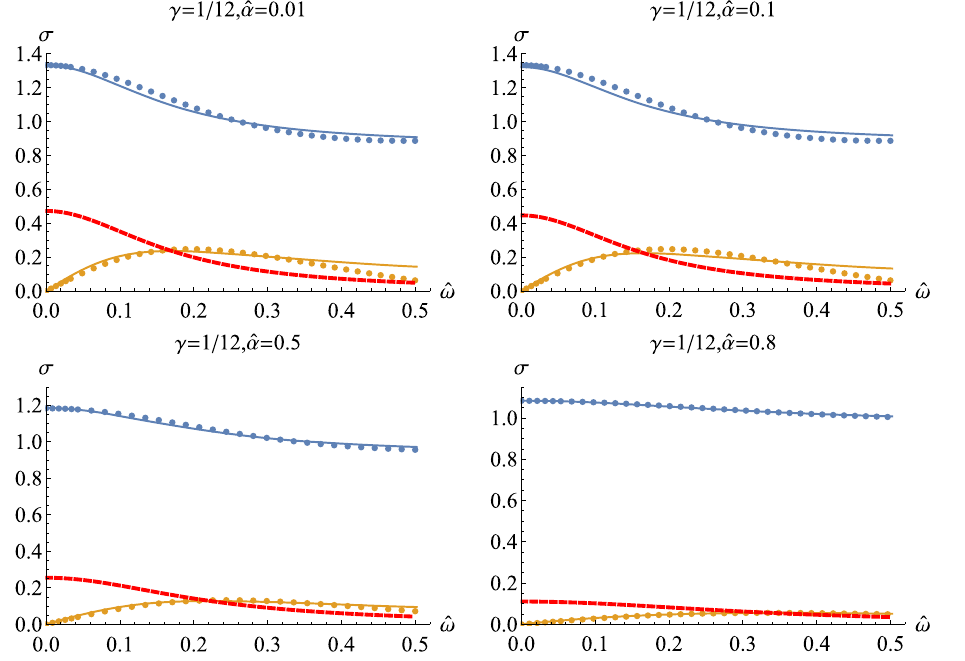
Fig. 3 The low frequency behavior of the optical conductivity with momentum dissipation for different ˆ α and γ = 1 / 12. They are fitted by a modified Drude formula (22). The red dashed line is the real part of